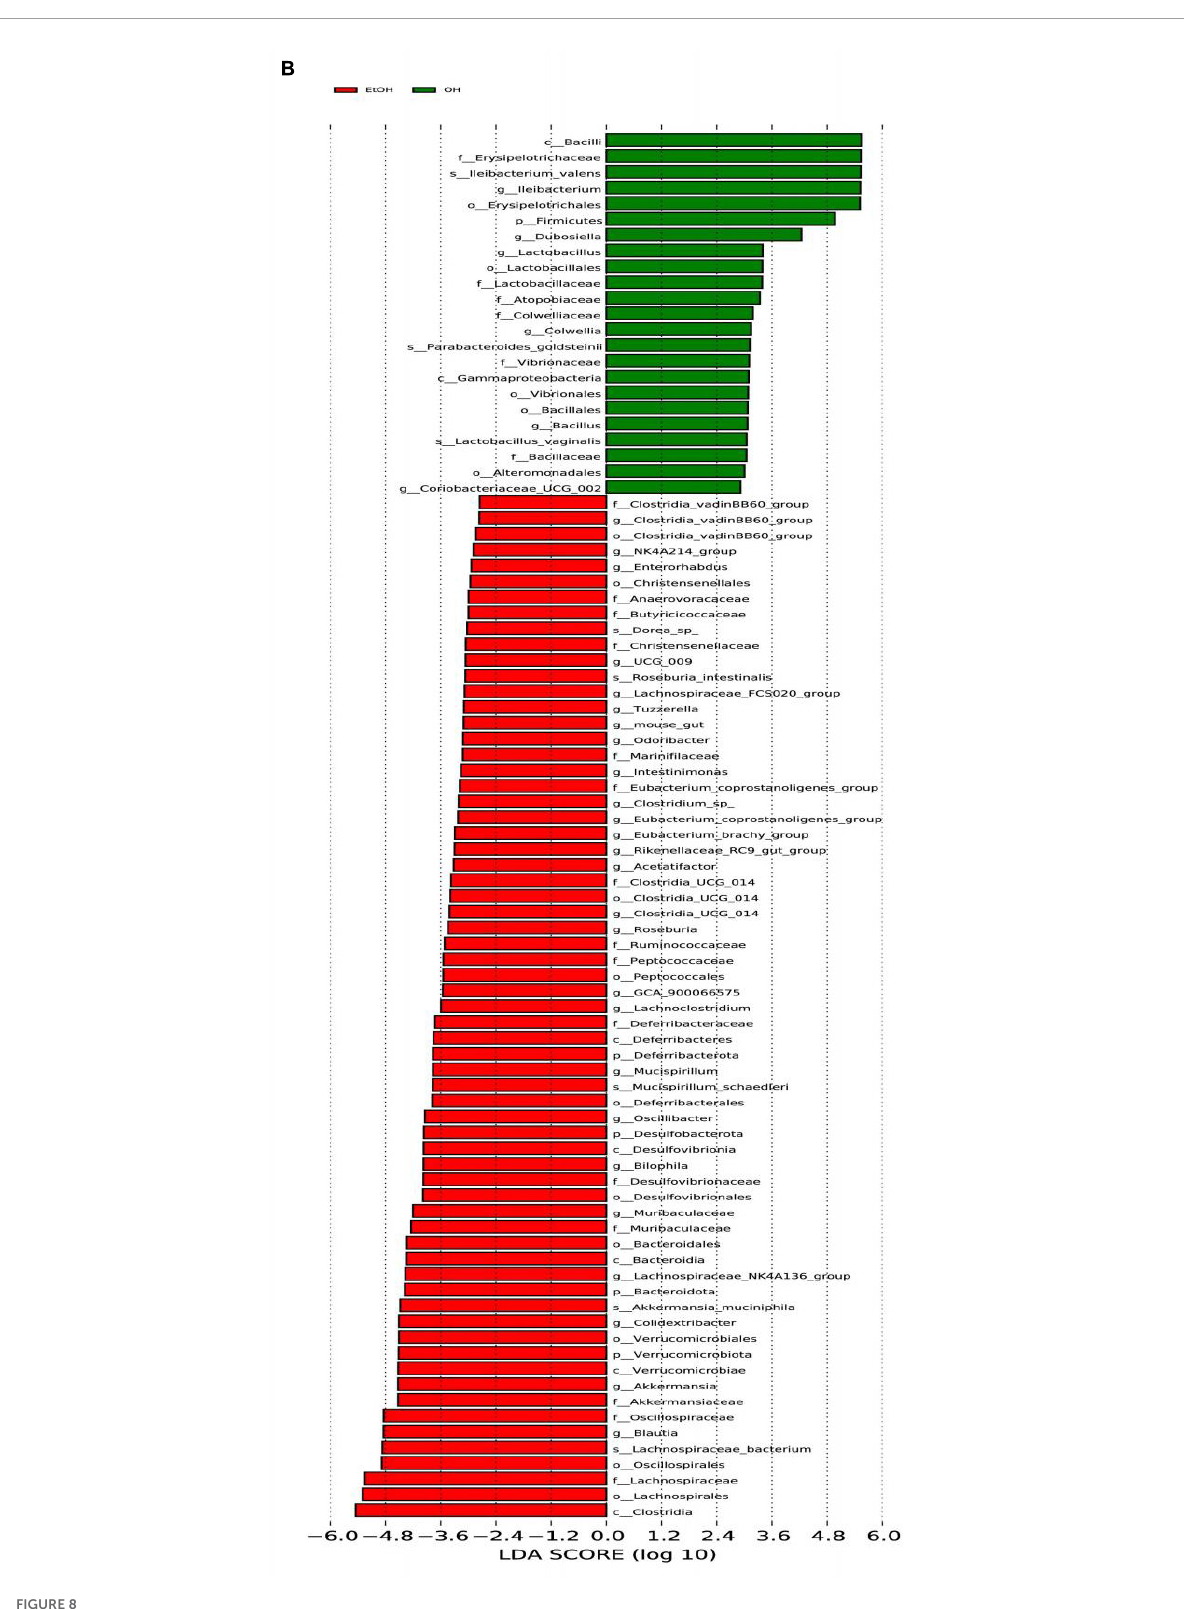
Frontiers in Nutrition